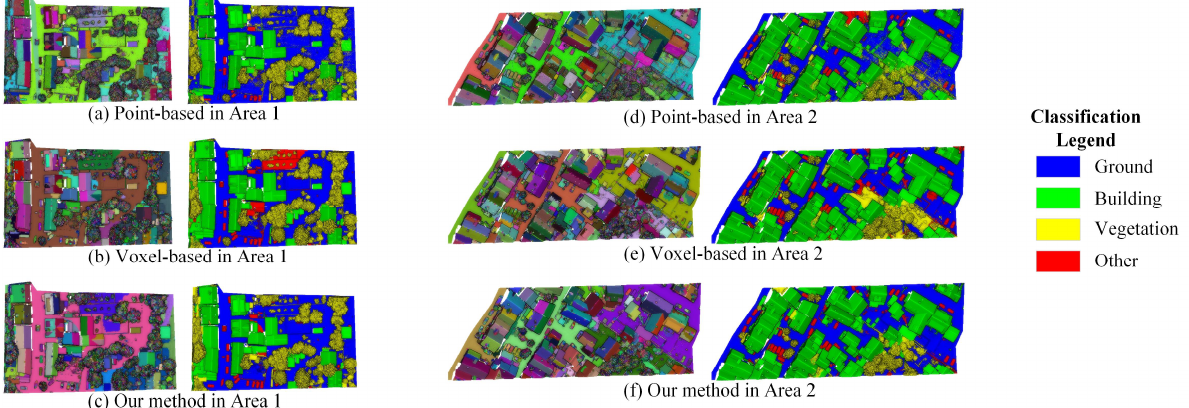
Figure 6. Segmentation results (left) and Classification results (right) in Area 1 and Area 2.